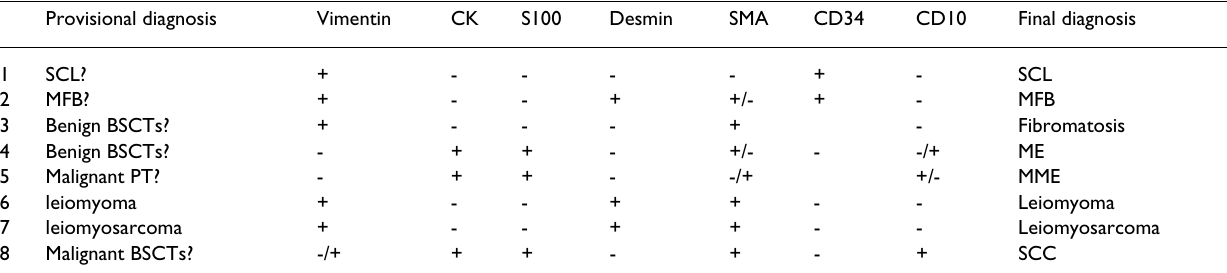
Table 3: IHC profile of the studied cases Provisional diagnosis